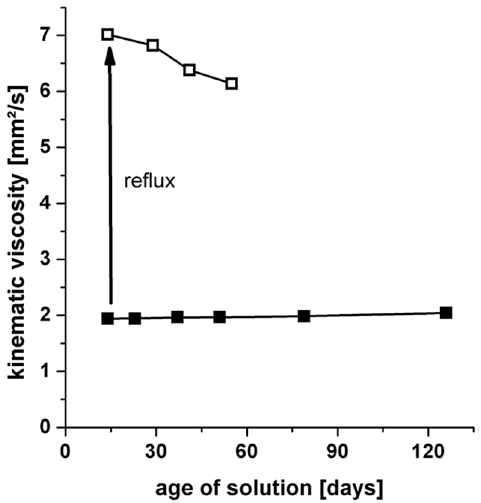
Figure 2. Viscosity of MgF 2 coating solutions as a function of the aging time. Reproduced from Reference [36] with the permission of the Royal Chemical Society.